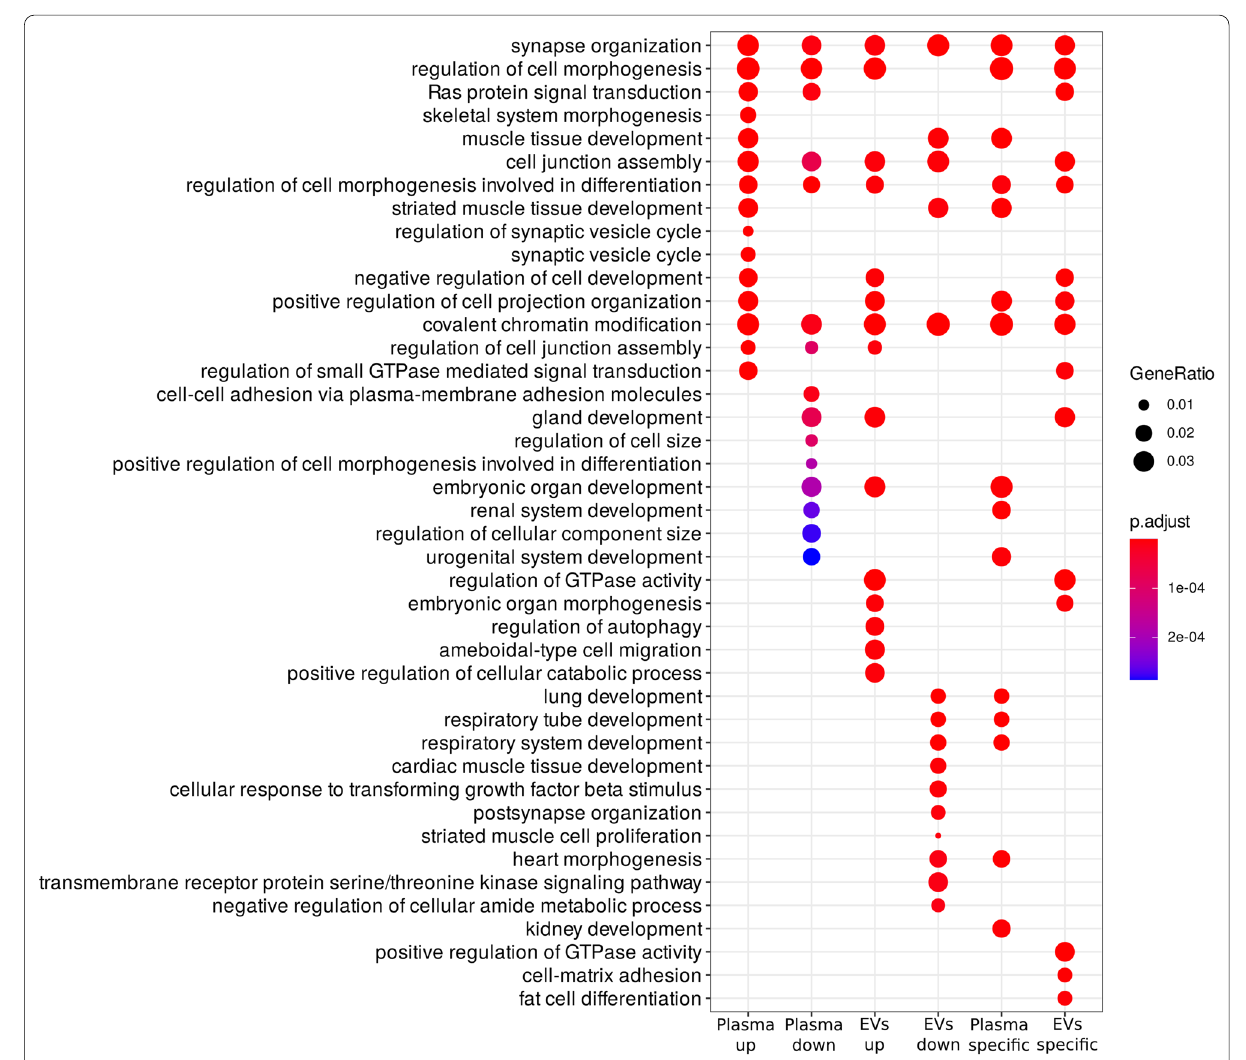
Fig. 3 Results of the GO enrichment analysis (top 15 terms for each group) among targets of differentially expressed miRNAs in plasma, extracellular vesicles, and between the two compartments (plasma up—analysis for miRNA up‑regulated in plasma, plasma down—analysis for miRNA down‑regulated in plasma, EVs up—analysis for miRNA up‑regulated in EVs, EVs down—analysis for miRNA down‑regulated in EVs, plasma specific—analysis for miRNA which abundance in plasma is higher than in EVs, in comparison to controls, EVs specific—analysis for miRNA which abundance in EVs is higher than in plasma, in comparison to